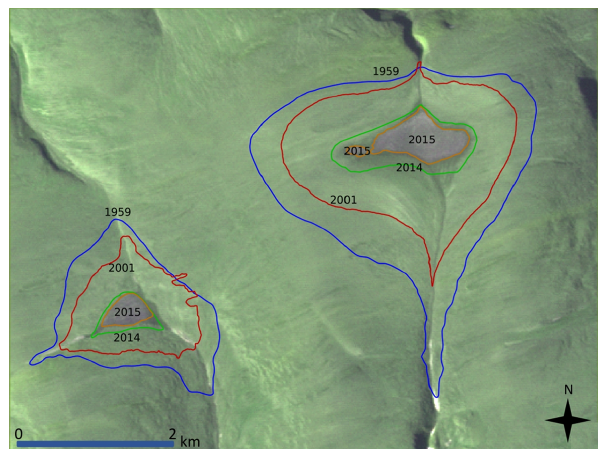
Figure 3. Outlines of the Murray and Simmons ice caps based on aerial photography from August 1959, GPS surveys conducted dur- ing August 2001, and for July 2016 from ASTER. The base image is from August